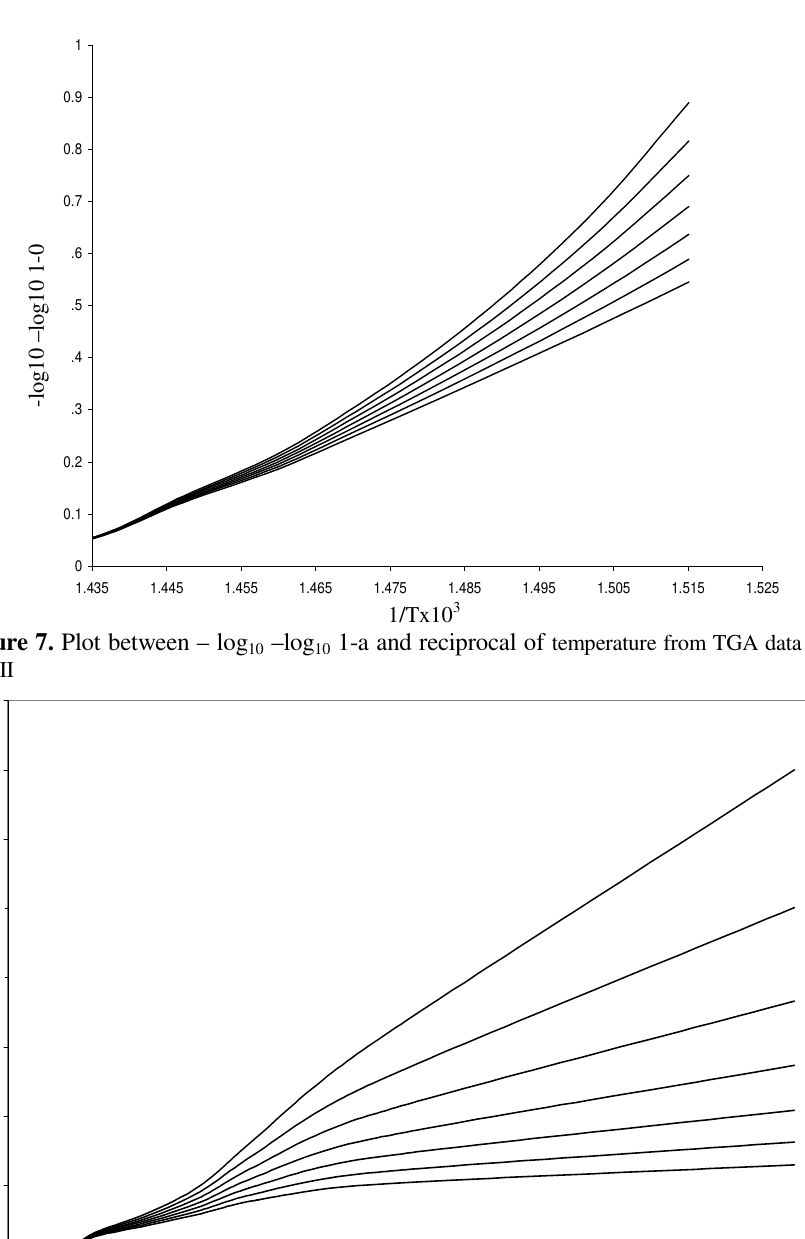
Figure 8. Plot between 1-1-a 1-n/1-n and reciprocal of temperature from TGA data for R